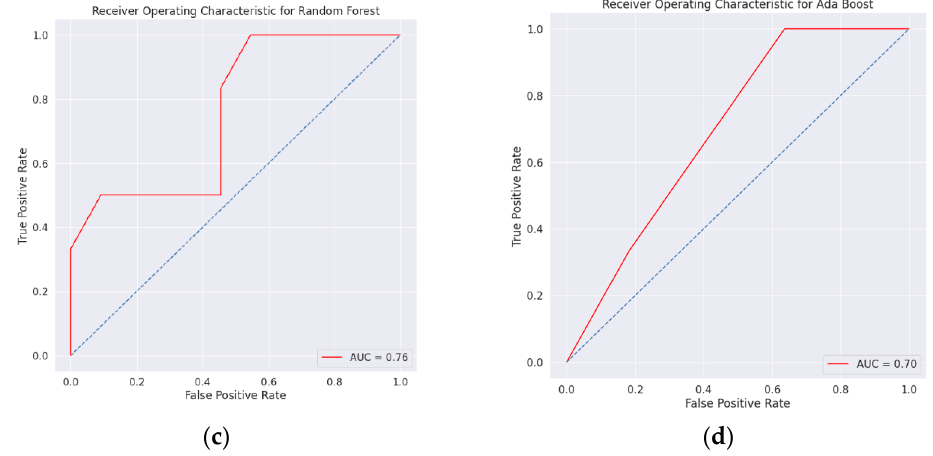
Figure 7. AUC score of ( a ) logistic classification, ( b ) decision tree, ( c ) random forest, and ( d ) AdaBoost algorithms.